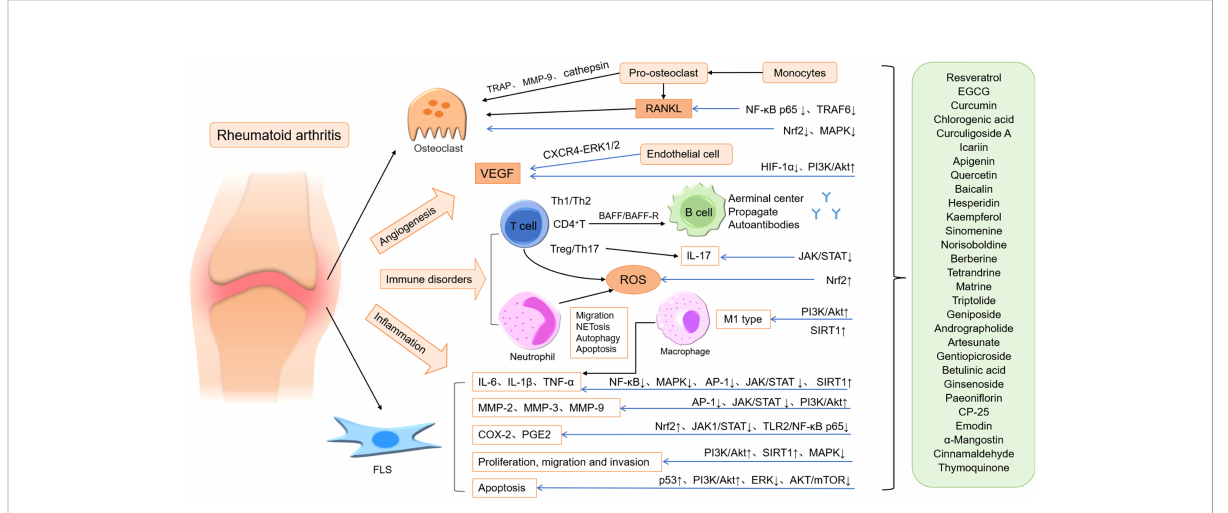
FIGURE 1 The main mechanism of natural medicines acting on RA. ↑ : increase, promote or up regulation; ↓ : decrease, down regulation or inhibit; Blue arrow: